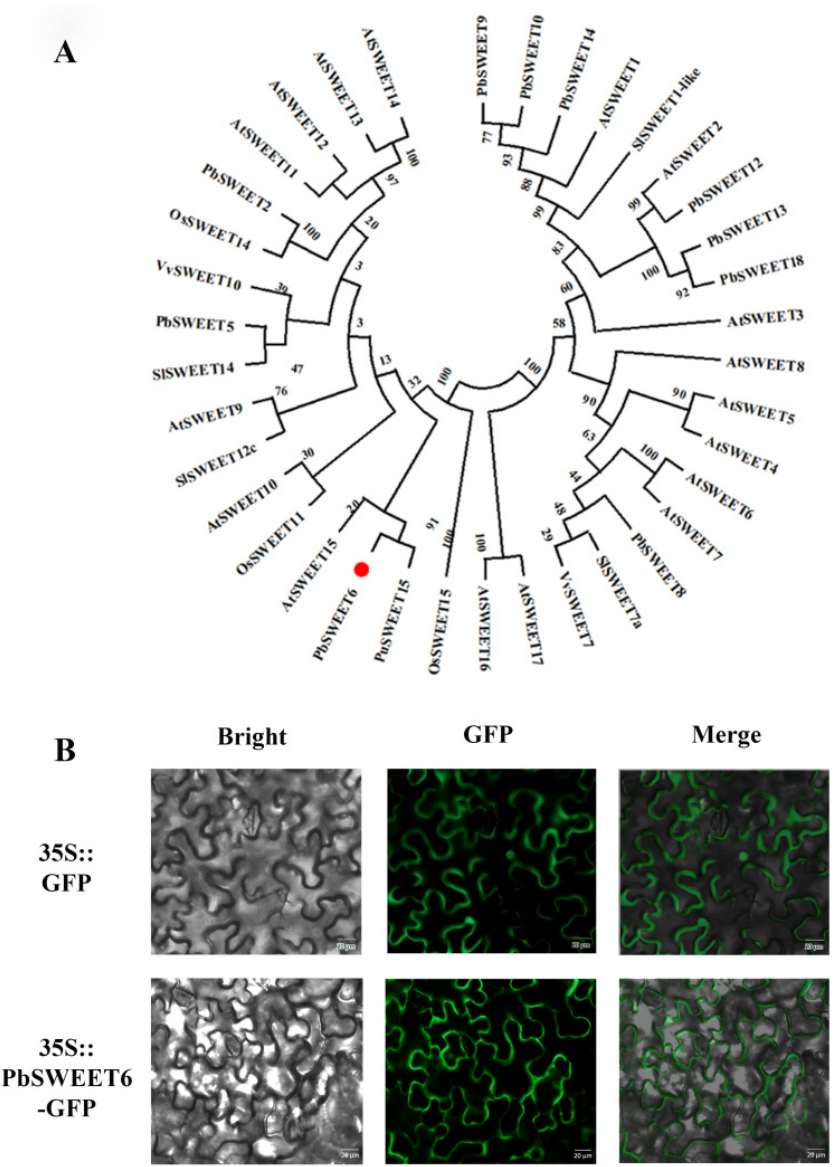
Figure 4. Phylogenetic and subcellular localization analysis of PbSWEET6. ( A ) Phylogenetic analysis of SWEET genes. The phylogenetic tree was inferred using the maximum likelihood method and JTT matrix-based model. PbSWEET6 protein is highlighted with red dots. ( B ) Localization of PbSWEET6. Bar = 20 μ m.